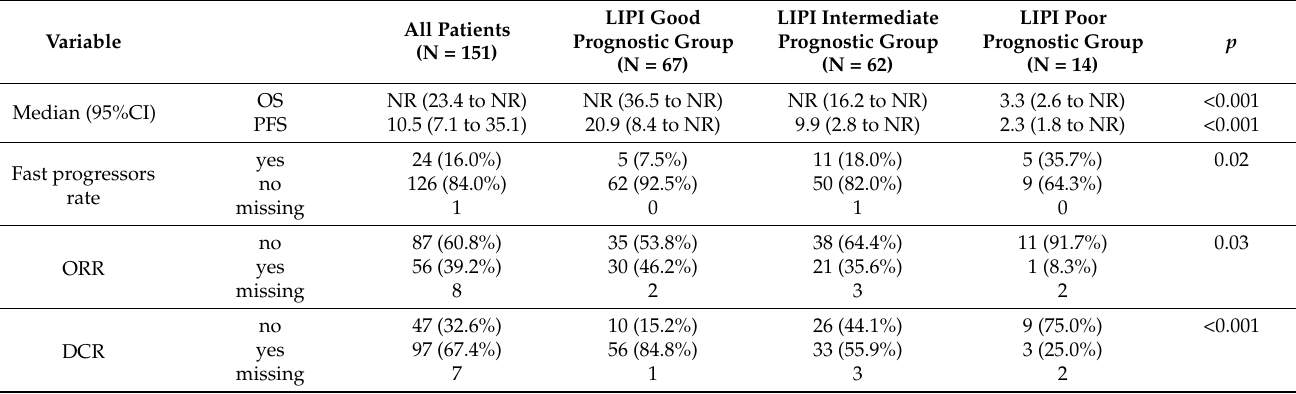
Table 2. Median survival and response endpoints according to the LIPI score.